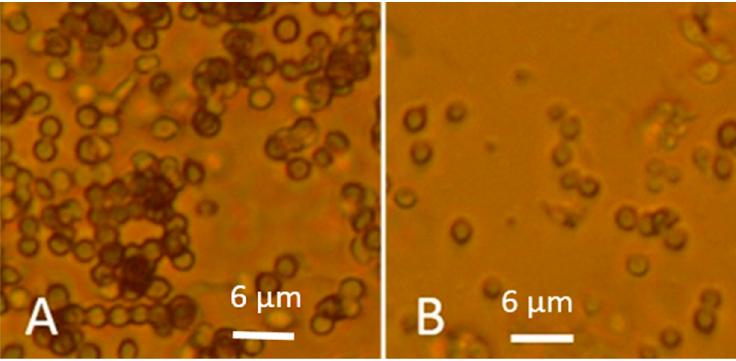
Figure 8. Phase contrast micrographs showing density of conidia in microscopic fields in dispersals of plate-grown biomasses (60 mg wet weight per mL) of Aspergillus versicolor SL/3. The dispersal of >1-year-old biomass in Panel ( A ) visualizes 120 conidia. Panel ( B ) shows the dispersal from a 2-weeks-old biomass containing 20 conidia. The panels ( A ) and ( B ) are representatives for 6 microscopic fields, respectively.